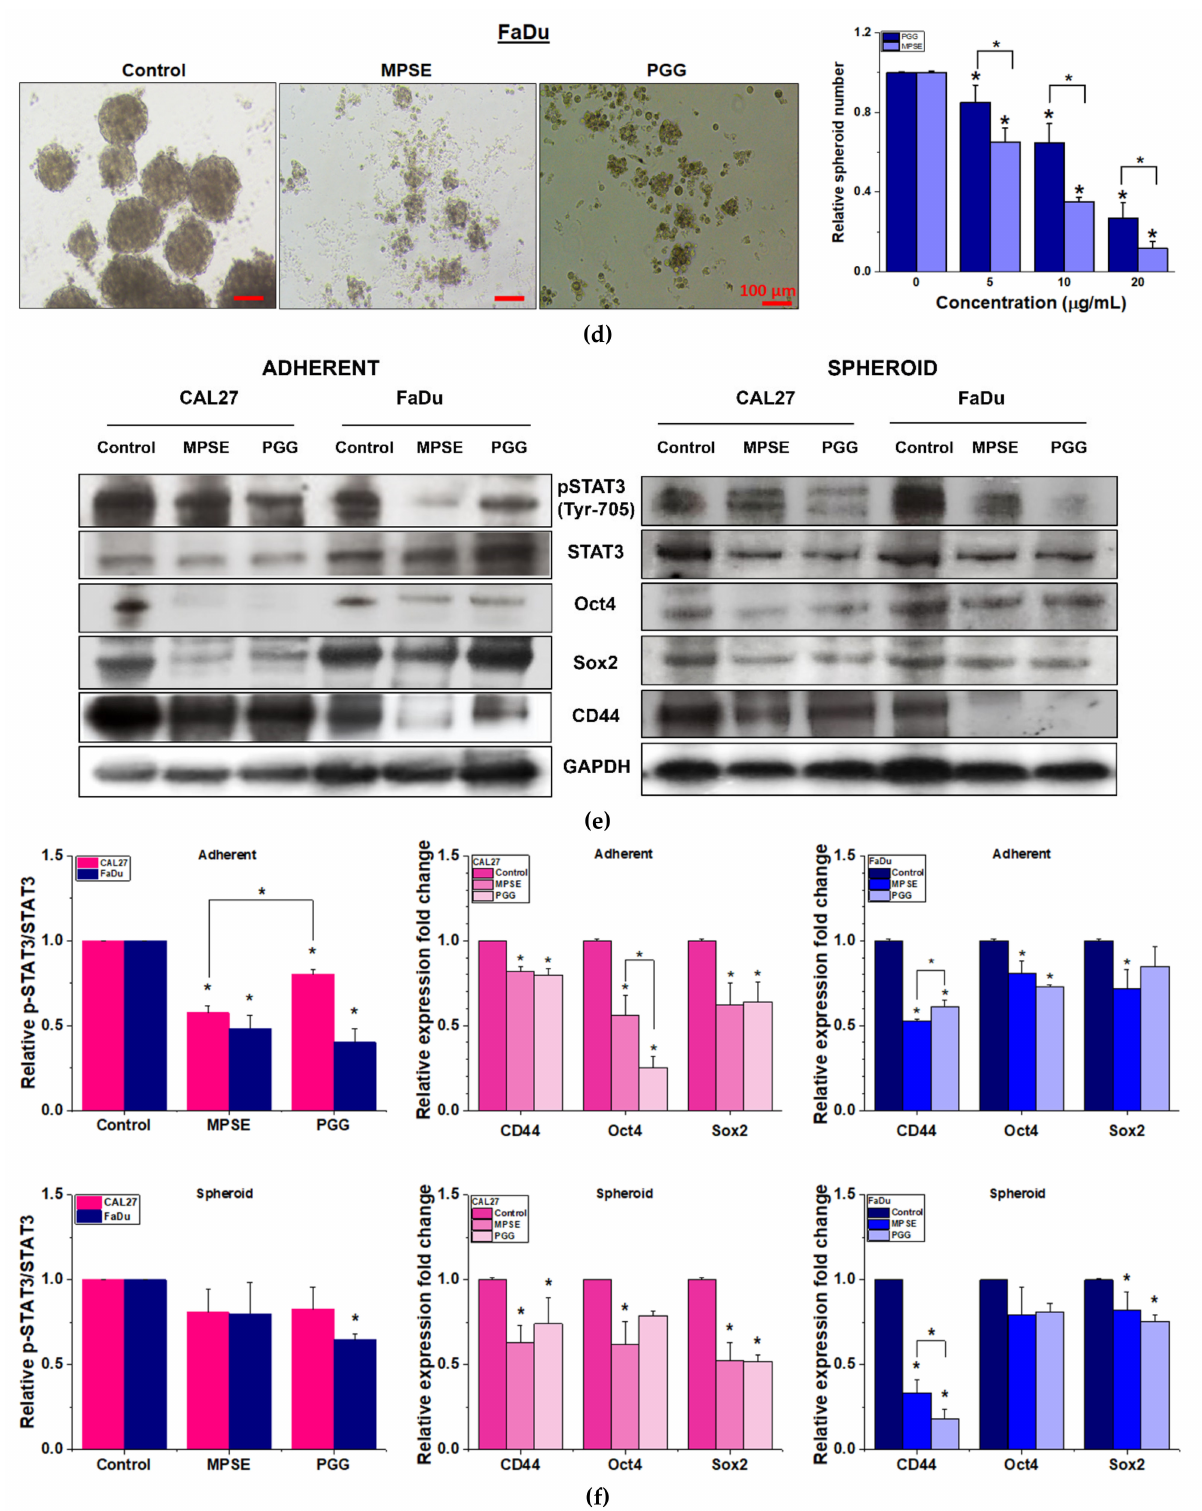
Figure 3. MPSE and PGG suppressed cancer stem-like cell phenotypes in HNSCC. ( a ) Left: representative images of spheroids derived from CAL27 and FaDu cells. Right: the protein expression of stem-cell markers in adherent